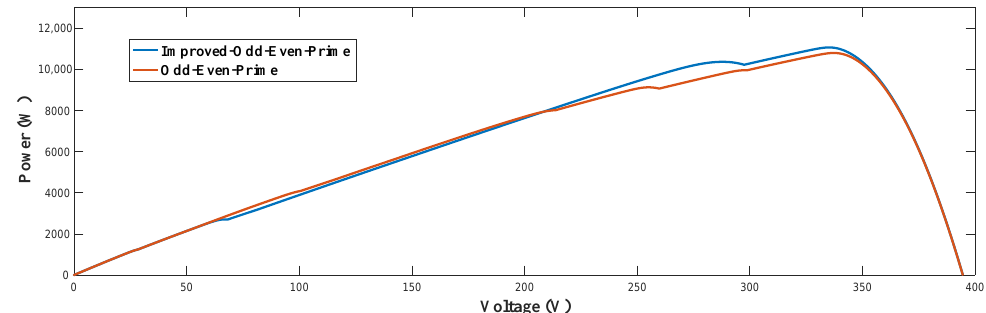
Figure 5. Voltage–power characteristics of 9 × 9 PV array for case-2 (Top-Right) PSC.